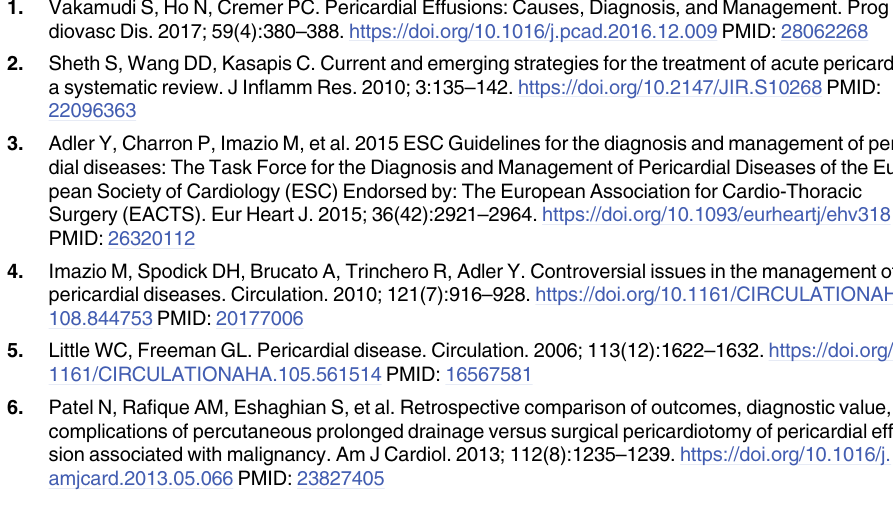
S3 Table. Adjusted outcomes stratified by pericardial effusion and tamponade (Reference: Surgical drainage). Abbreviations: AOR , adjusted odds ratio; 95% CI , 95% confidence inter- val; LOS , length of stay. S4 Table. Adjusted outcomes stratified by etiology of pericardial effusion (Reference: Sur- gical drainage). Abbreviations: AOR , adjusted odds ratio; 95% CI , 95% confidence interval; LOS , length of